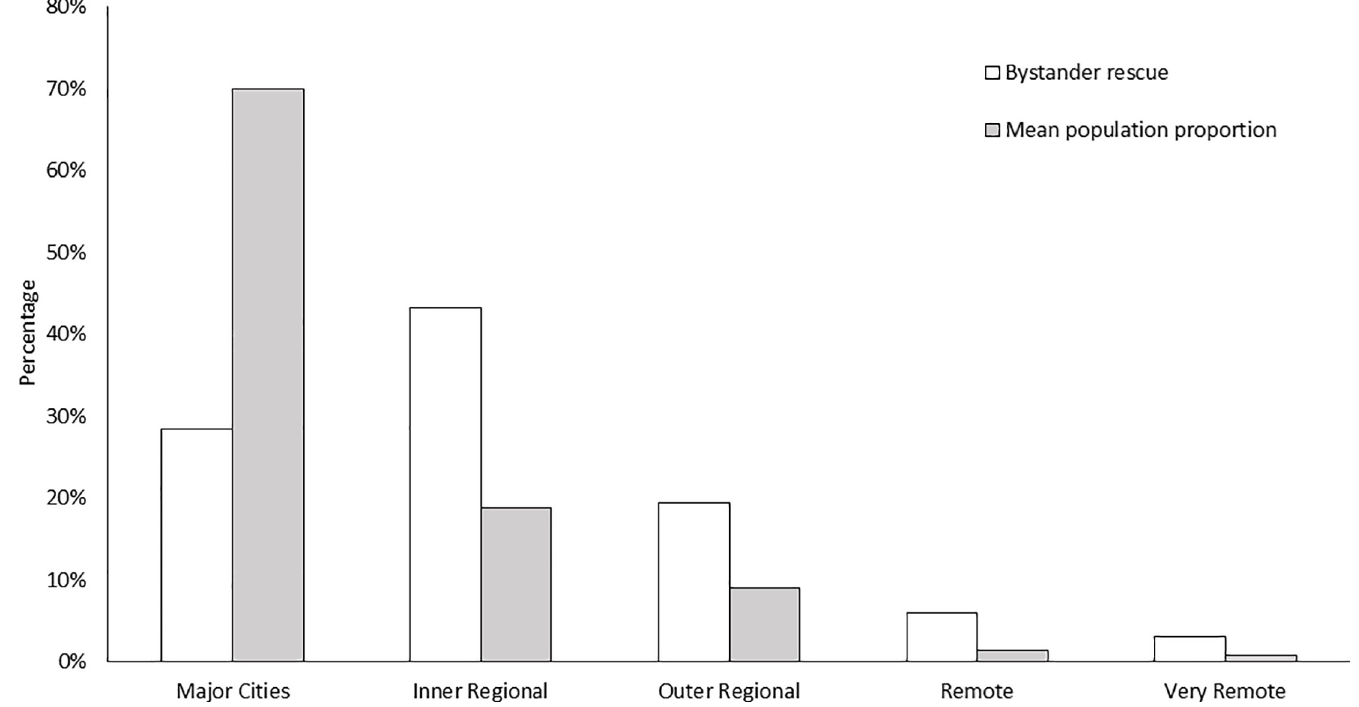
Fig 3. Remoteness classification of incident locations compared with mean population proportions